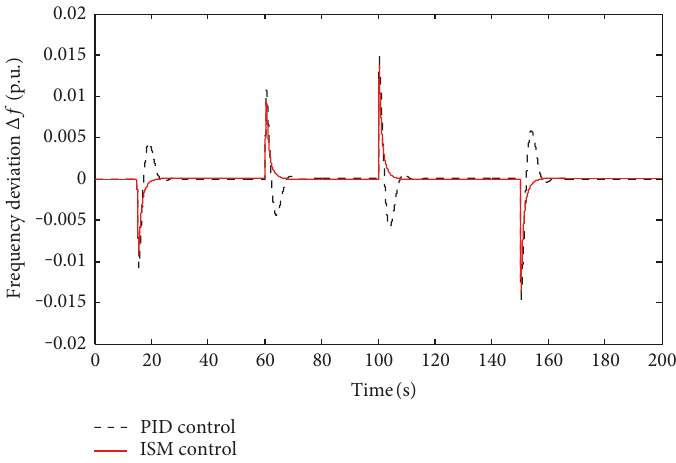
Figure 4: The frequency deviation without power output constraints.